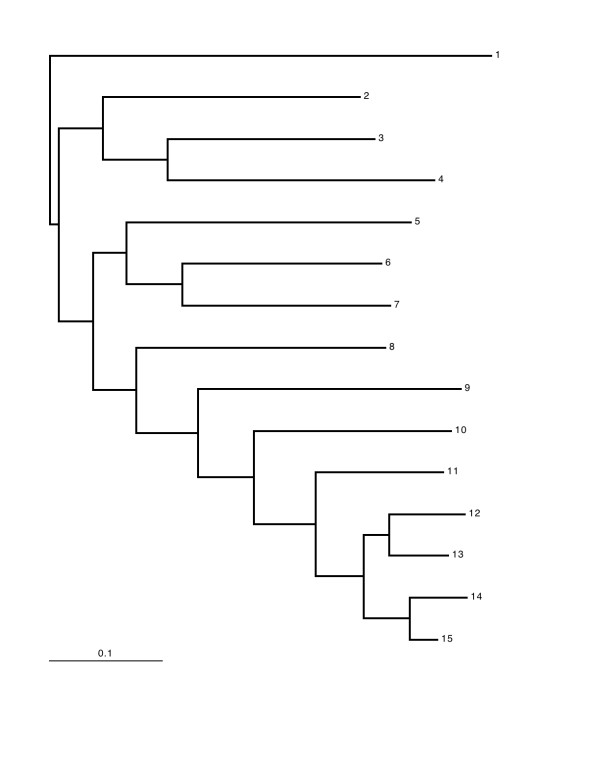
The 15 taxa tree used in the simulation study.